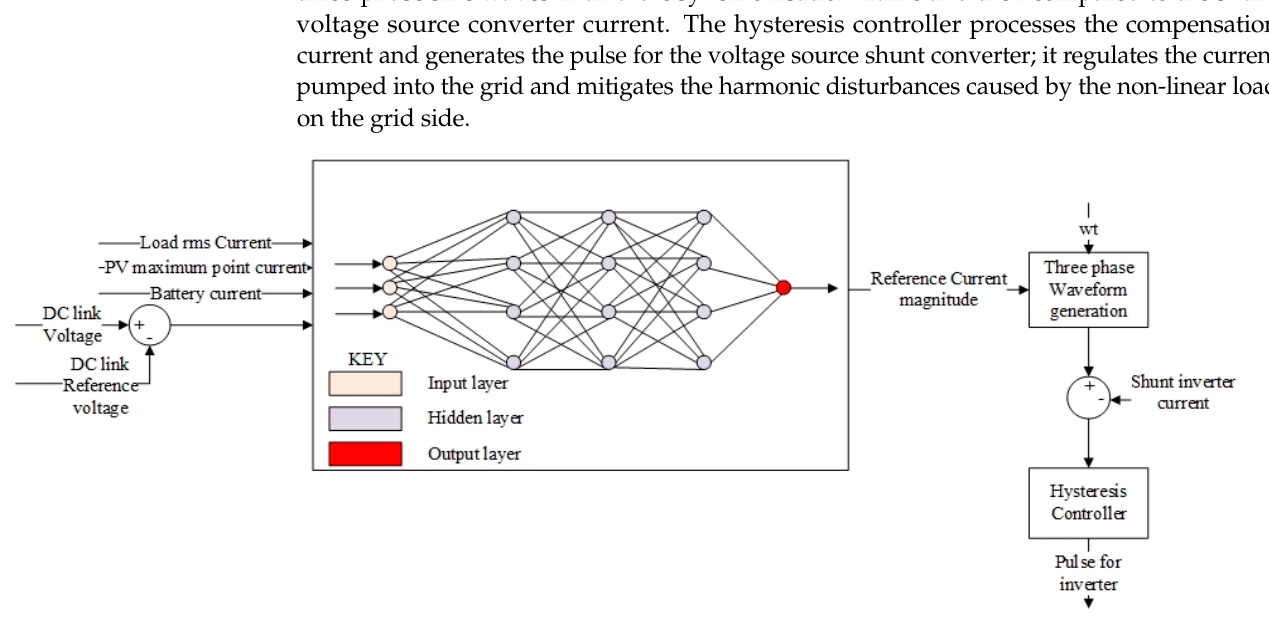
Figure 4. Shunt voltage source converter control logic model.